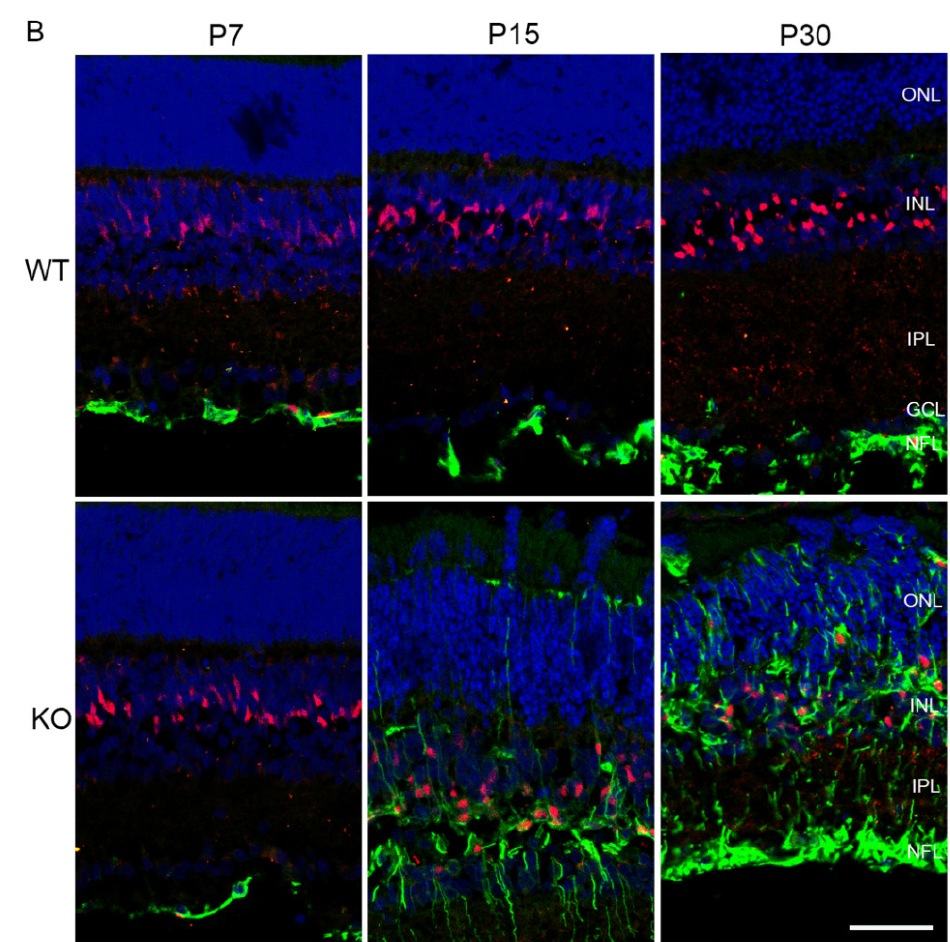
Figure 6. Müller glial activation in Rs1 -/Y rat retina. Retinas of WT and Rs1 -/Y rats were immuno- labeled for microglia and macrophages (Iba1) and Müller glia (SOX9 and GFAP) at P7, P15, and P30. ( A ) Iba1-IR (red) cells were mainly shown in the ganglion cell layer, inner nuclear layer (GCL, INL) and synaptic layers in the WT retinas. Slightly increased levels of Iba1 cells were found at P7 in the KO retinas. Microglial activation was more noticeable at P15 and P30 of the KO retinas. At P30, Iba1 cells migrated into the ONL and subretinal regions in the KO retinas. Scale bar = 100 µ m. ( B ) Upregulated expression of GFAP-IR (green) in Müller glia was evident at P15 and P30 in Rs1-KO. Only the nerve fiber layer (NFL) and GCL in the WT retina showed GFAP labeling. In the KO retina, GFAP expression at P7 was also restricted to the NFL and GCL. Still, between P15 and P30, GFAP labeling gradually extended across all layers, suggesting Müller hypertrophy and reactive gliosis. At P15 and P30, Müller glia nuclei (SOX9, red) were displaced compared to the WT retina. Scale bar = 50 µ